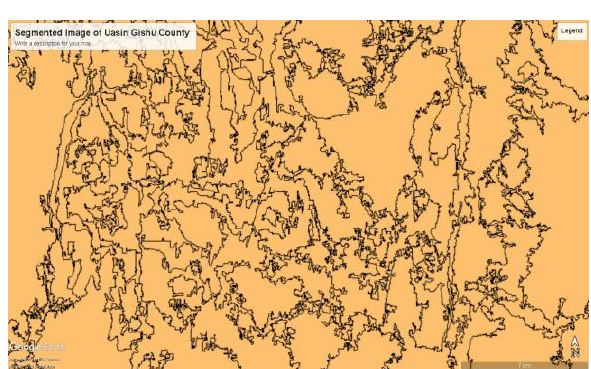
Figure 2. Segmented image of the study area with scale parameter 800, shape 0.1 and compactness 0.5